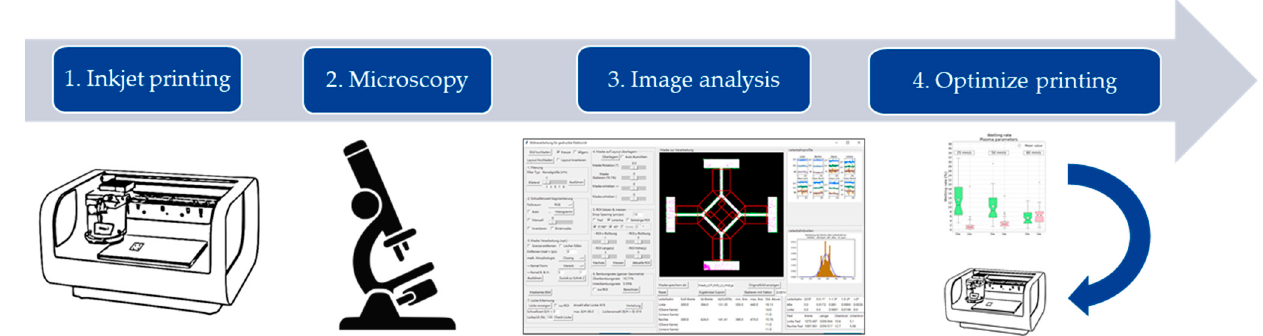
Figure 1. Workflow for improving the print quality in inkjet printing based on an image analysis evaluation.